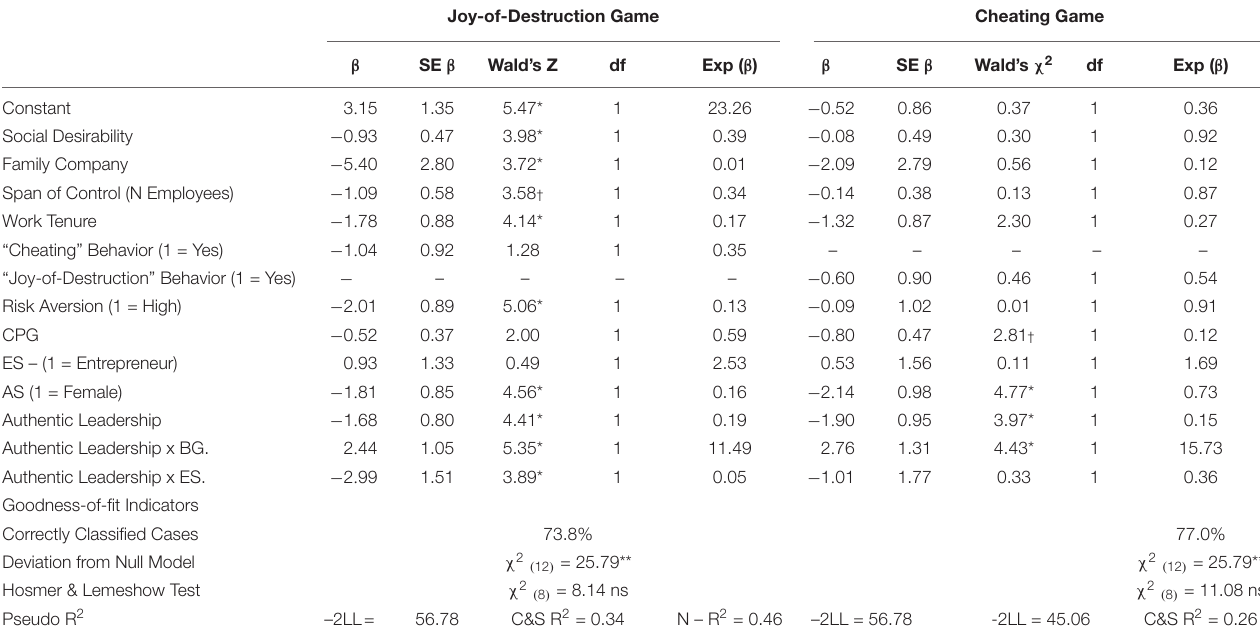
TABLE 3 | Phase 2 – Logistic Regression model predicting the likelihood of displaying two antisocial behaviors ( N = 62). Joy-of-Destruction Game